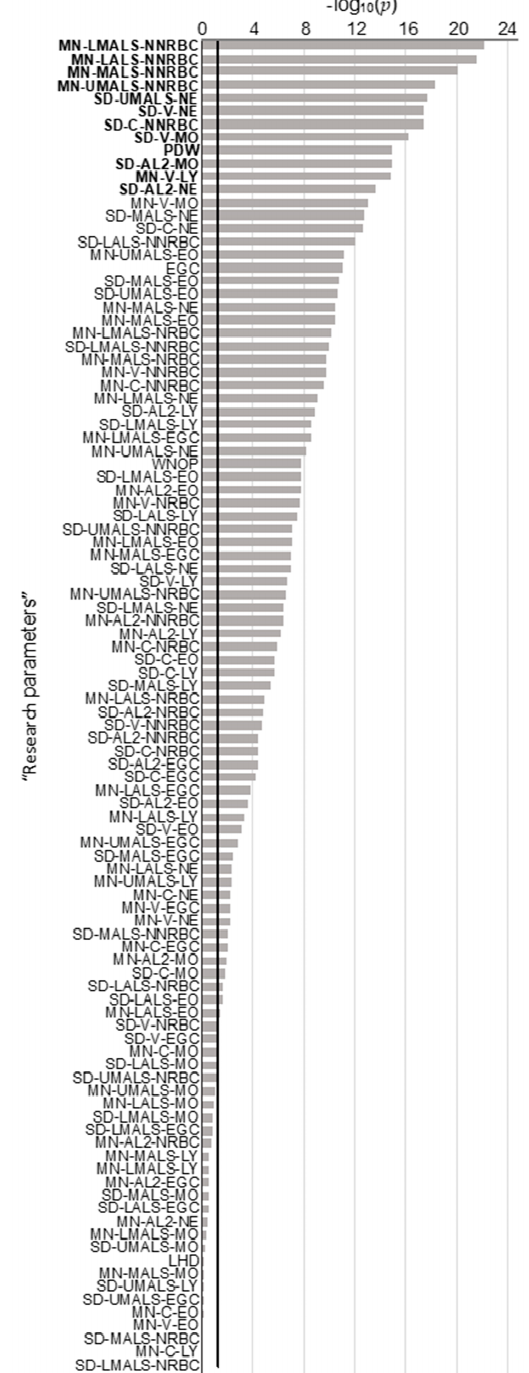
Figure 1. p -Values of monoparametric comparisons of each “research parameter” from myelodys- plastic syndromes (MDS) patients and healthy volunteers. Parameters with values above the 5% threshold (black line y = − log10(0.05)) are significantly different between MDS patients and healthy volunteers. MN: Mean; SD: Standard deviation; LMALS: Low Median Angle Light Scatter; NNRBC: Non-Nucleated Red Blood Cells; LALS: Low Angle Light Scatter; MALS: Median Angle Light Scatter; UMALS: Upper Median Angle Light Scatter; NE: Neutrophils; V: Volume, MO: Monocytes; PDW: Platelet Distribution Width; AL2: Axial Light Loss; C: Conductivity; EGC: Early Granulated Cells; LY: Lymphocytes; WNOP: WBC estimate (corrected) from the NRBC Optical Channel, EO: Eosinophils; NRBC: Nucleated Red Blood Cells, LHD: Low Hemoglobin